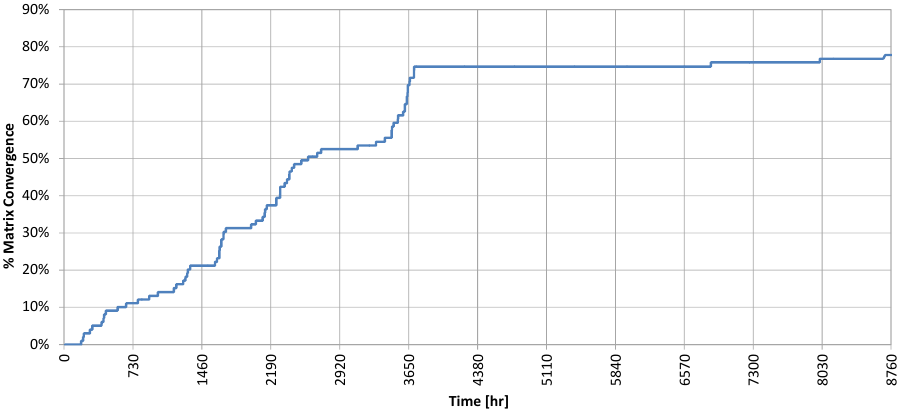
Figure 10. Exploration factor (ξ) as a function of time.